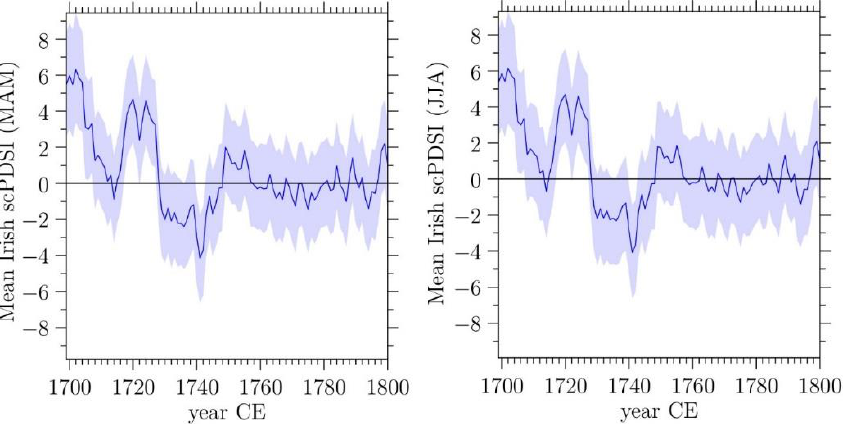
Figure A3. 18th century scPDSI for MAM ( left ) and JJA ( right ). Since they are based on the same data but with slightly different weights, they are almost